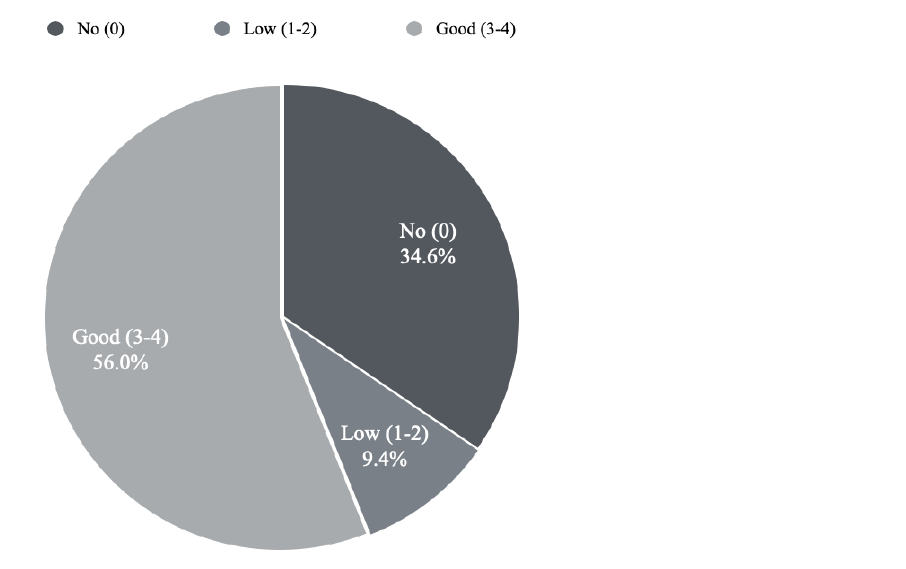
Figure 2. The knowledge of RFS among participants. Three levels of knowledge were measured. No knowledge, low, and good.